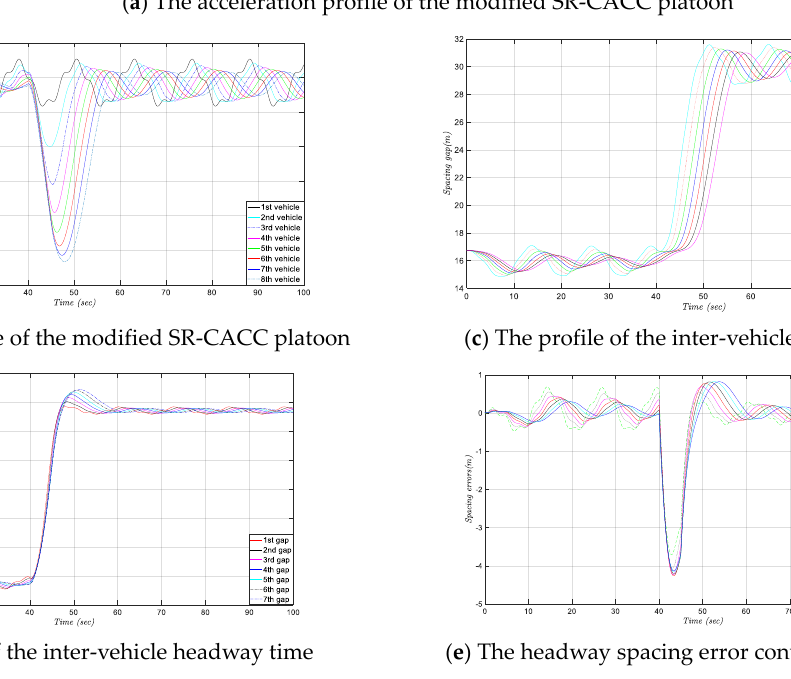
Figure 8. Simulation experiment results of the SR-CACC platoon with a smooth transition.